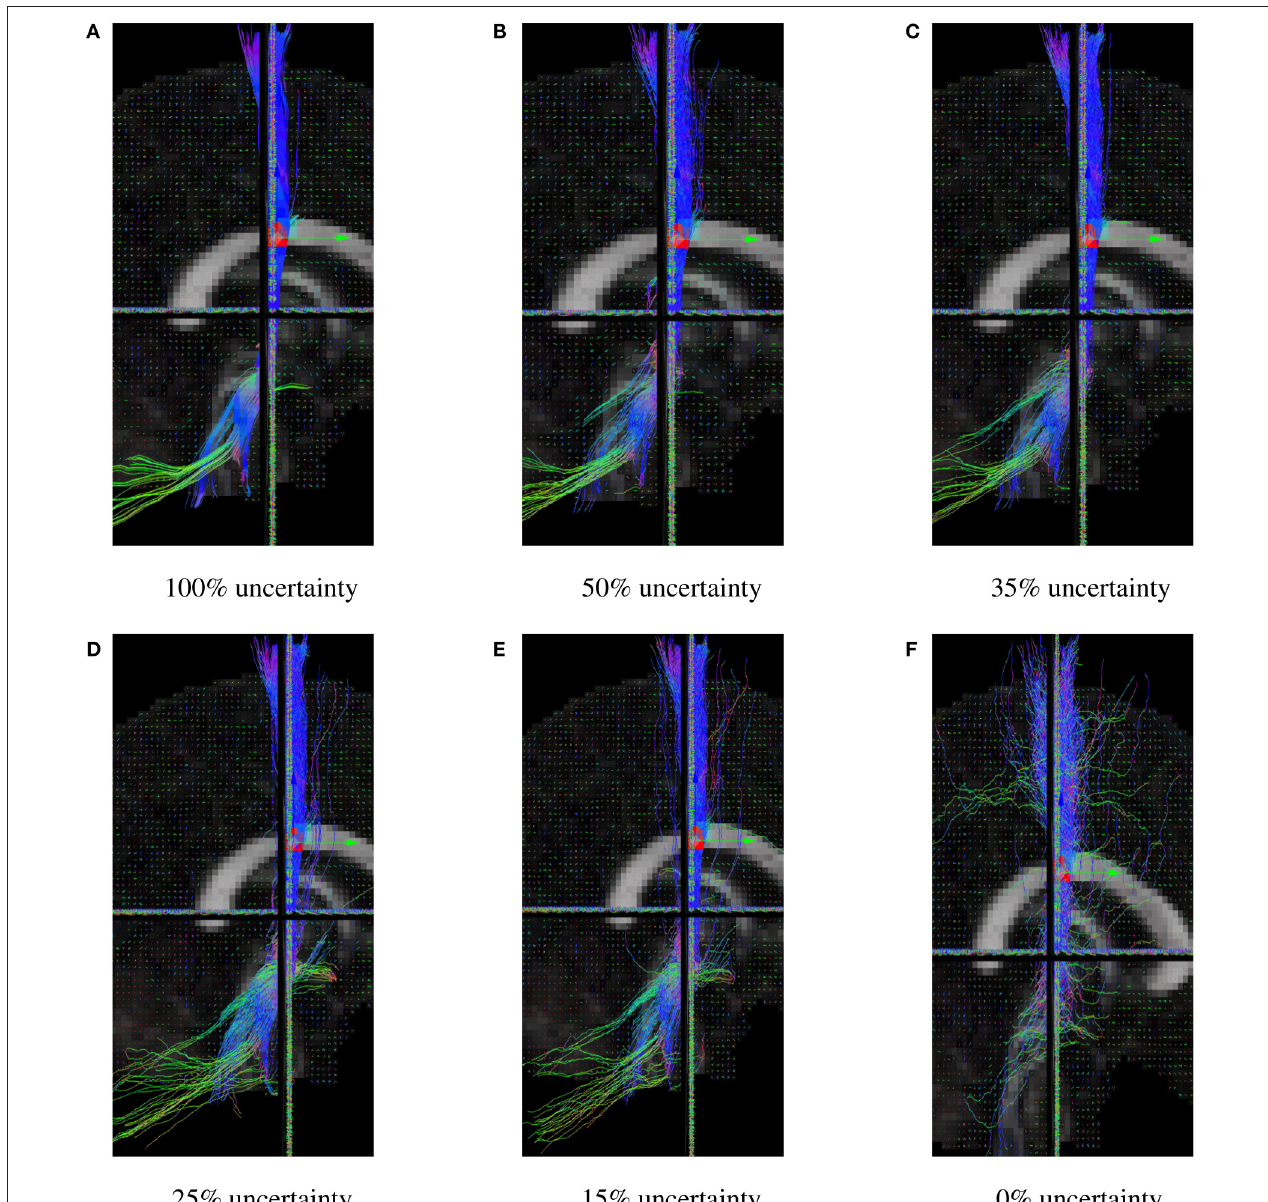
FIGURE 8 | CST bundles resulting from probabilistic tractography, with a varying uncertainty percentage threshold. (A) Results of the Fiberweb algorithm for 100% uncertainty. (B) Results of the Fiberweb algorithm for 50% uncertainty. (C) Results of the Fiberweb algorithm for 35% uncertainty. (D) Results of the Fiberweb algorithm for 25% uncertainty. (E) Results of the Fiberweb algorithm for 15% uncertainty. (F) Results of the Fiberweb algorithm for 0%